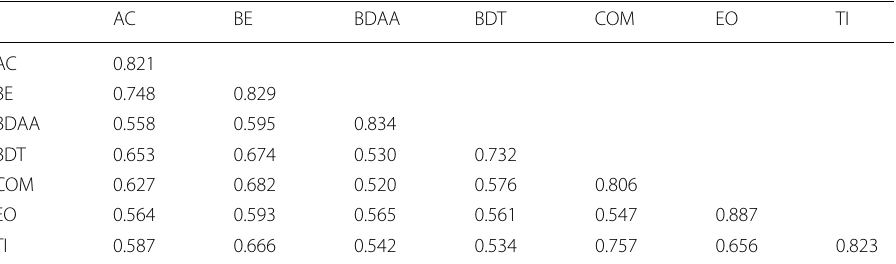
Table 4 Discriminant validity